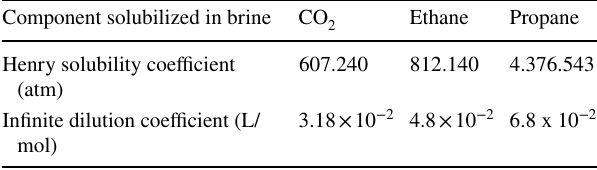
Table 1 Solubility parameters of supercritical compounds in brine Component solubilized in brine CO 2 Ethane